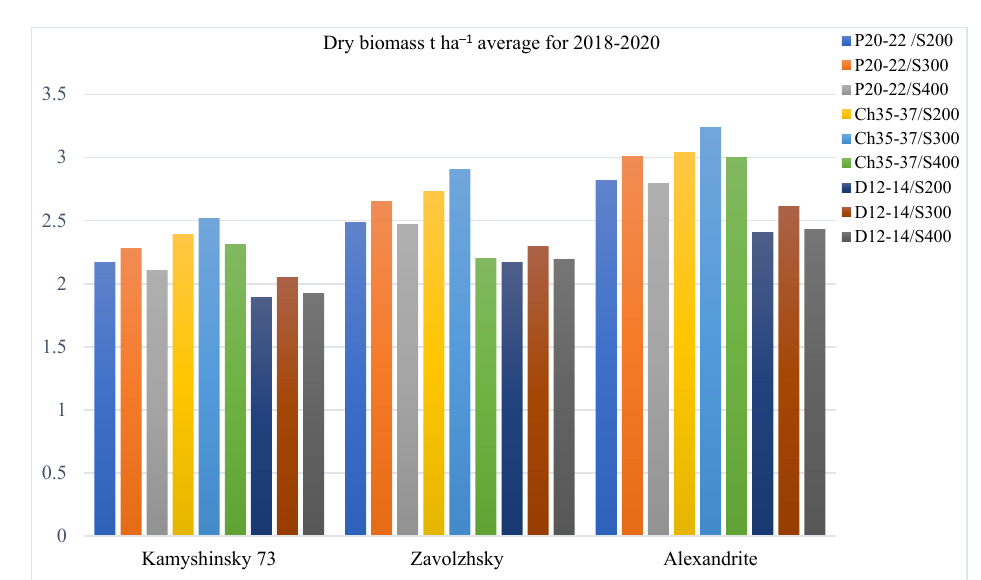
Figure 1. Interactive effect of different tillage techniques and seeding rates on dry biomass of safflower. Abbreviations: P20–22/S200 represents moldboard plow PN-4-35 with depth of 20–22